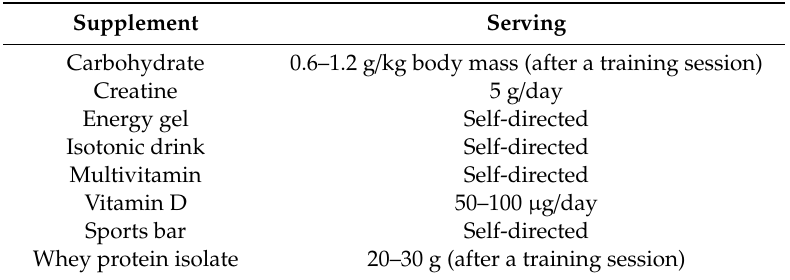
Table 3. Table 3. Supplements used by the players including serving